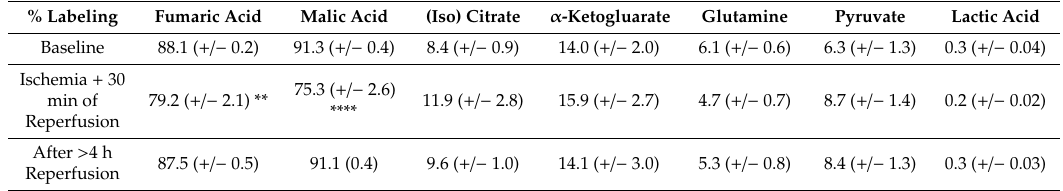
Table 1. 13 C-labeling % for selected metabolites in the ET-1 model. Data is shown as mean +/ − SEM of 4 rats. Significant di ff erences using nonparametric Kruskal Wallis test with Dunn’s multiple comparison’s test (vs. baseline) are shown: ** p < 0.005 and **** p < 0.0001.